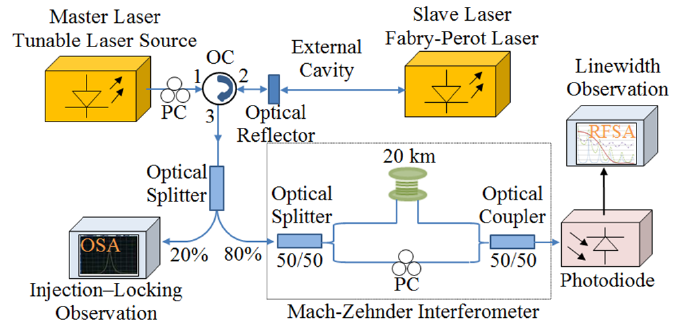
Figure 7. Schematic of test system for verifying IL in optical and radio spectra.